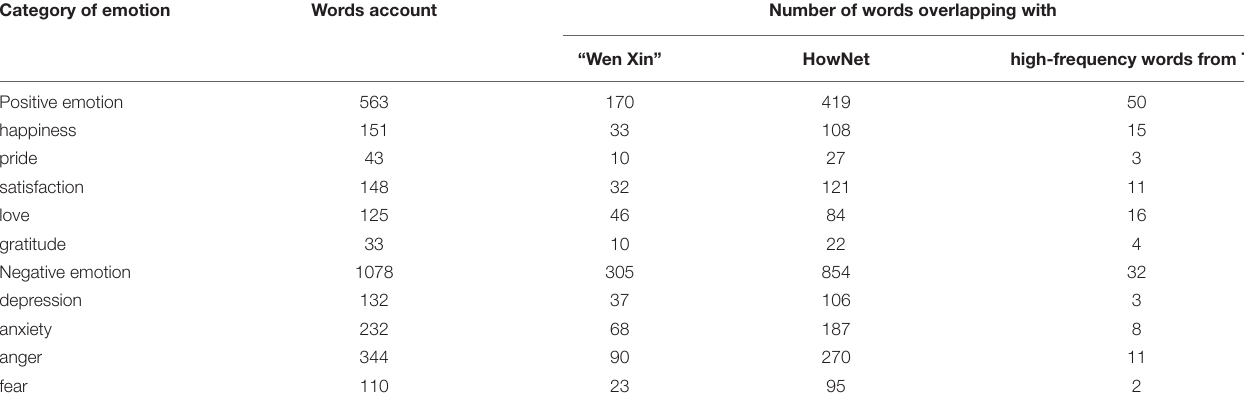
TABLE 1 | The constructed dictionary suitable for TT